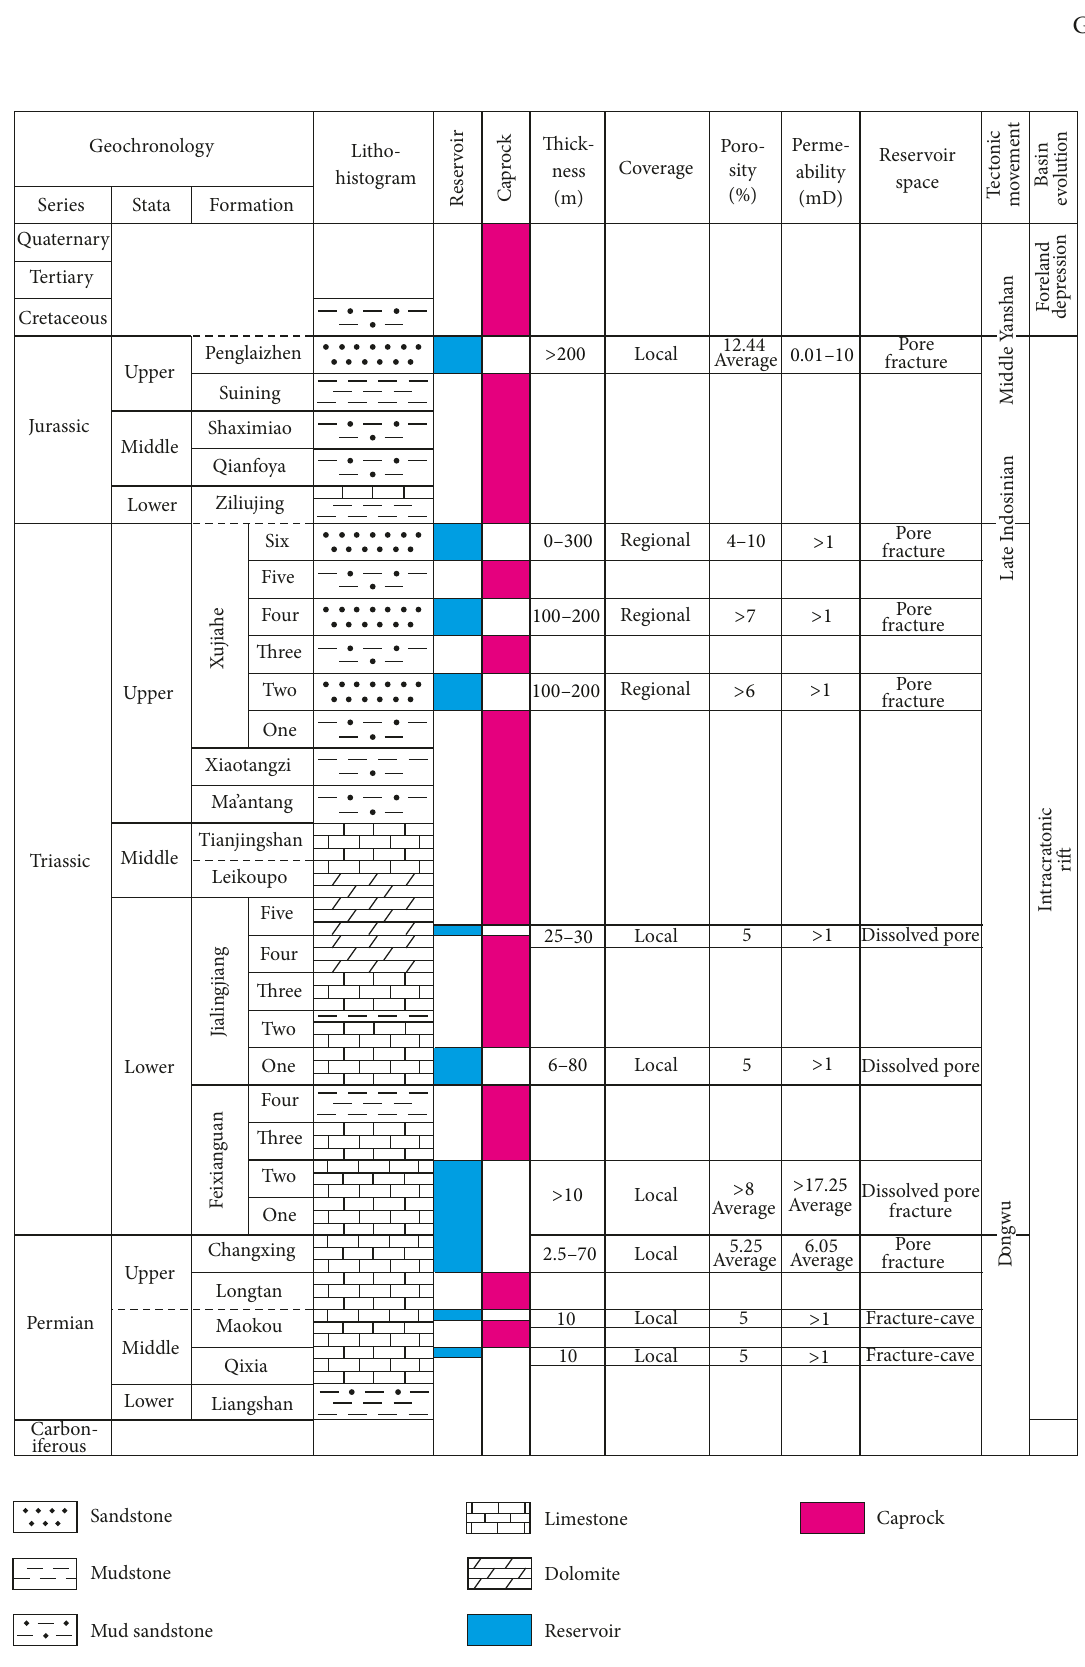
Figure 5: CO 2 geological storage vertical reservoir cap combination in the Sichuan Basin. There are nine sets of reservoirs in the Sichuan Basin, and the section four of Xujiahe group is the primary reservoir with large thickness and area, which almost cover the whole